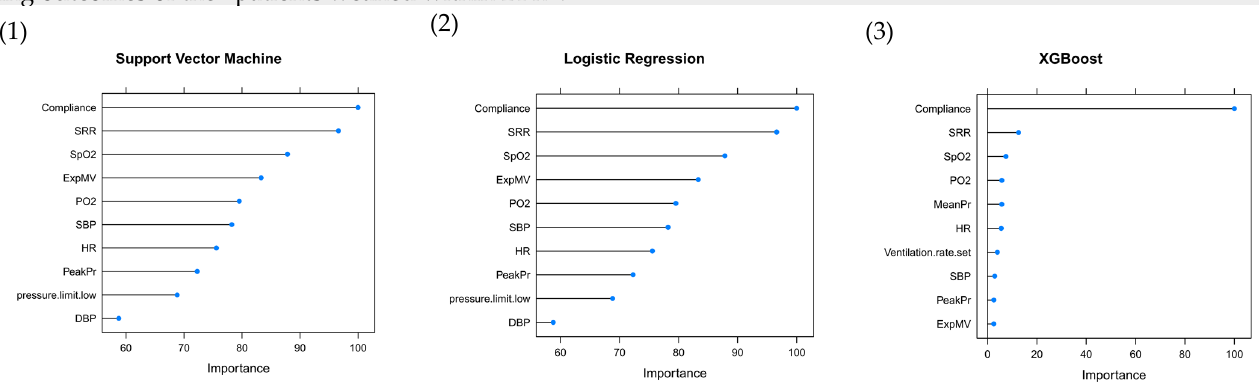
Figure 4. Feature importance for the machine learning methods in the proposed algorithm. Top ten variables ranked by feature importance and used by the three machine learning models [( 1 ) support vector machine, ( 2 ) logistic regression, and ( 3 ) XGBoost] to predict patient weaning within 24 h.